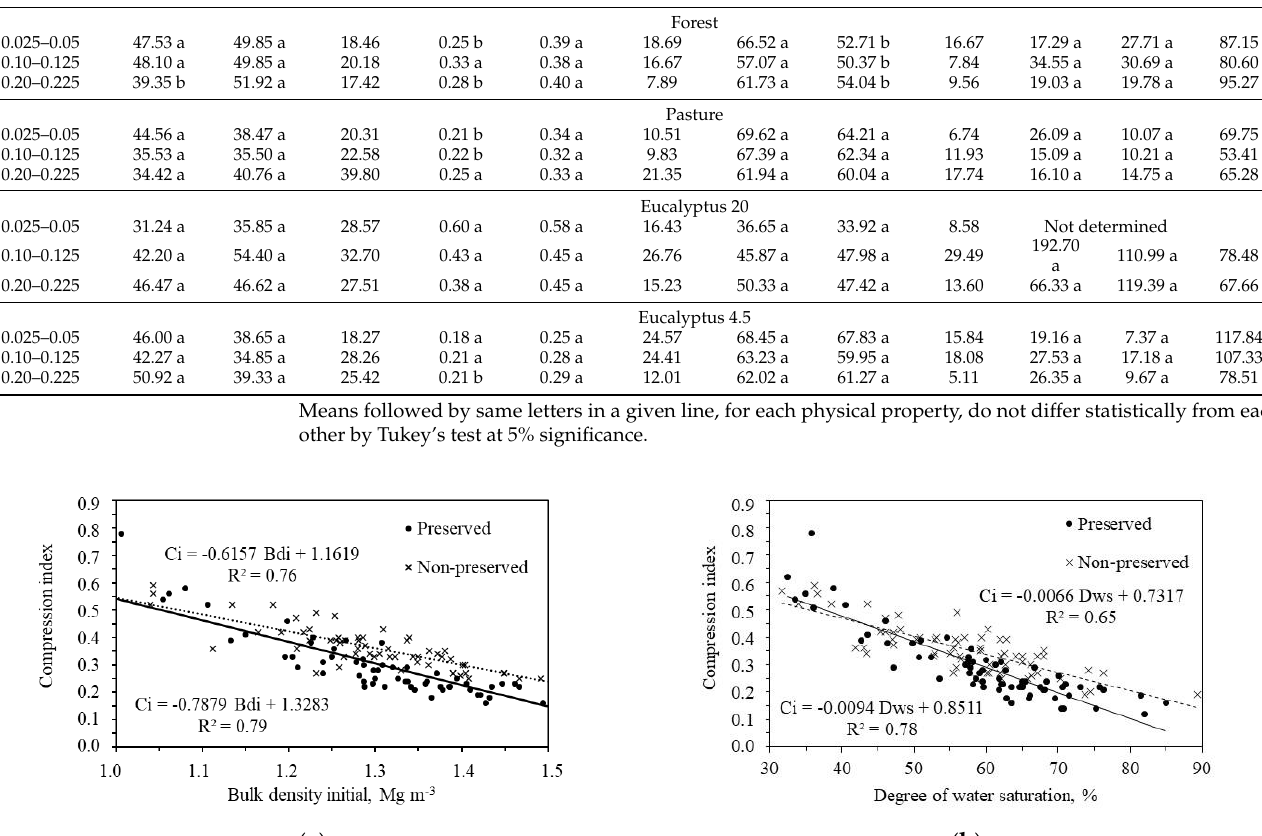
Figure 8. Regression between physical properties for soil with preserved and non-preserved struc- ture. Macro = macroporosity; Micro = microporosity; Dws = degree of water saturation. Soil structure condition (preserved or not) had few influences on bulk density, macroporosity, total porosity, air permeability, and precompression stress ( p > 0.05). How- ever, for loads greater than the precompression stress (load greater than 200 kPa), the soil with non-preserved structure had greater deformation. The results show that compaction reduced macropores and air flow; as a consequence the soil experienced less deformation with further loading and was less susceptible to additional compaction.